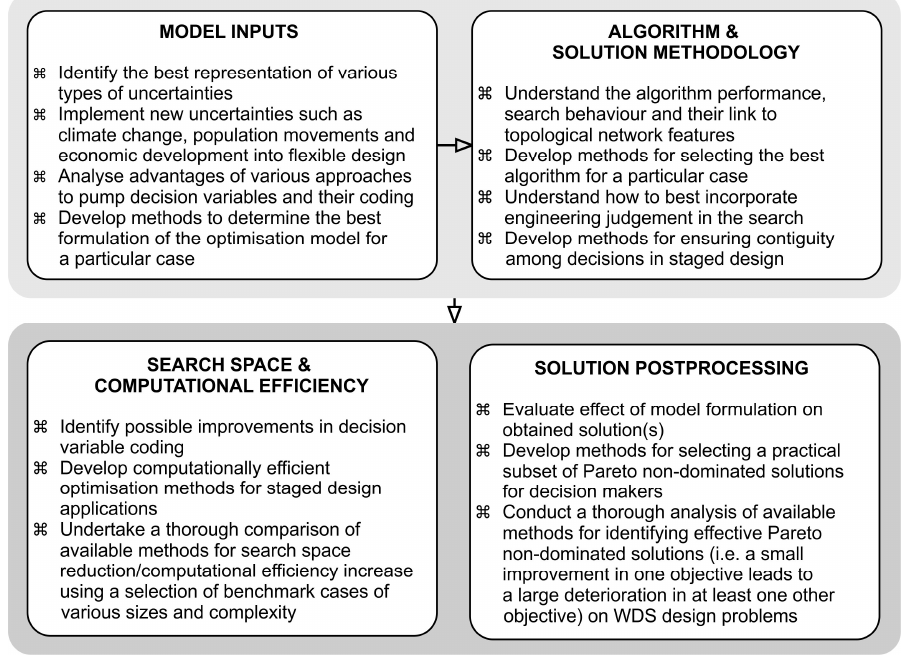
Figure 6. Future research challenges.